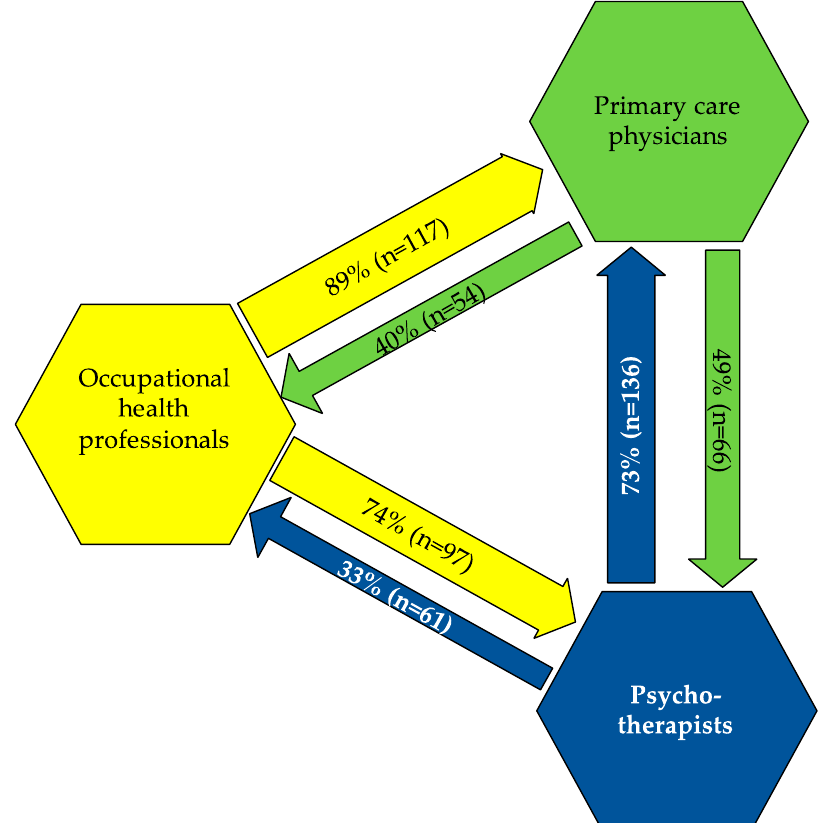
Figure 1. Experience of a successful approach to get in contact with the respective other professions regarding primary, secondary or tertiary prevention of common mental disorders in employees from three perspectives. Percentages and numbers are based on the valid answers.